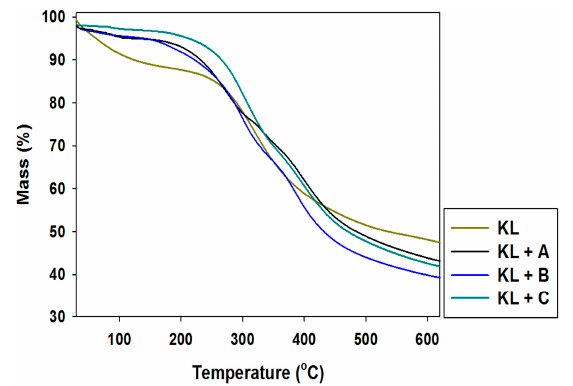
Figure 5. Thermogravimetric curves of kraft lignin (KL) and activated lignins by selected ionic liquids: